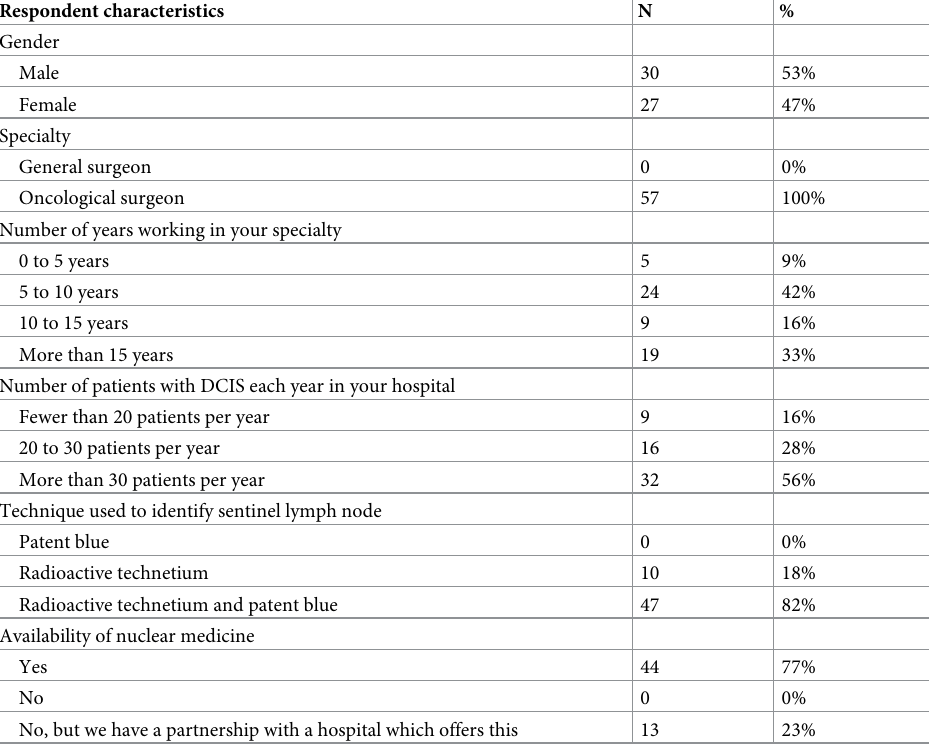
Table 1. Respondent characteristics of the first responding surgeon of each